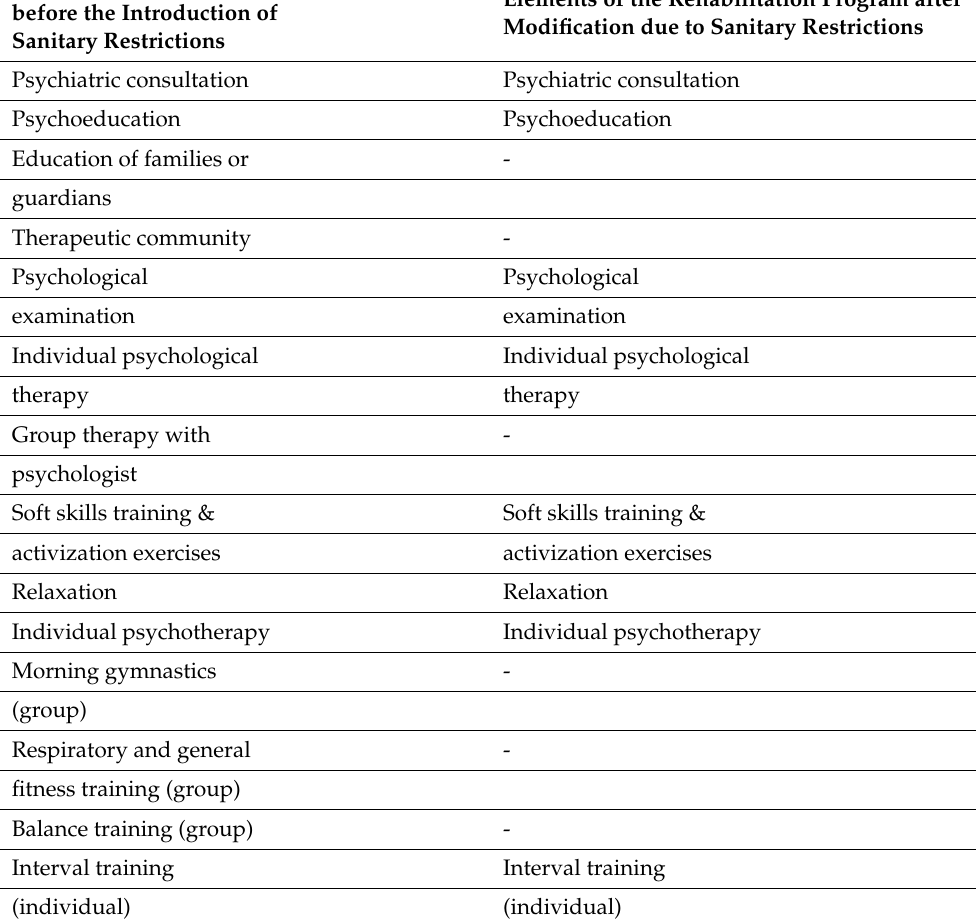
Table 1. Elements of the rehabilitation program before and after the introduction of sanitary restrictions. Elements of the Rehabilitation